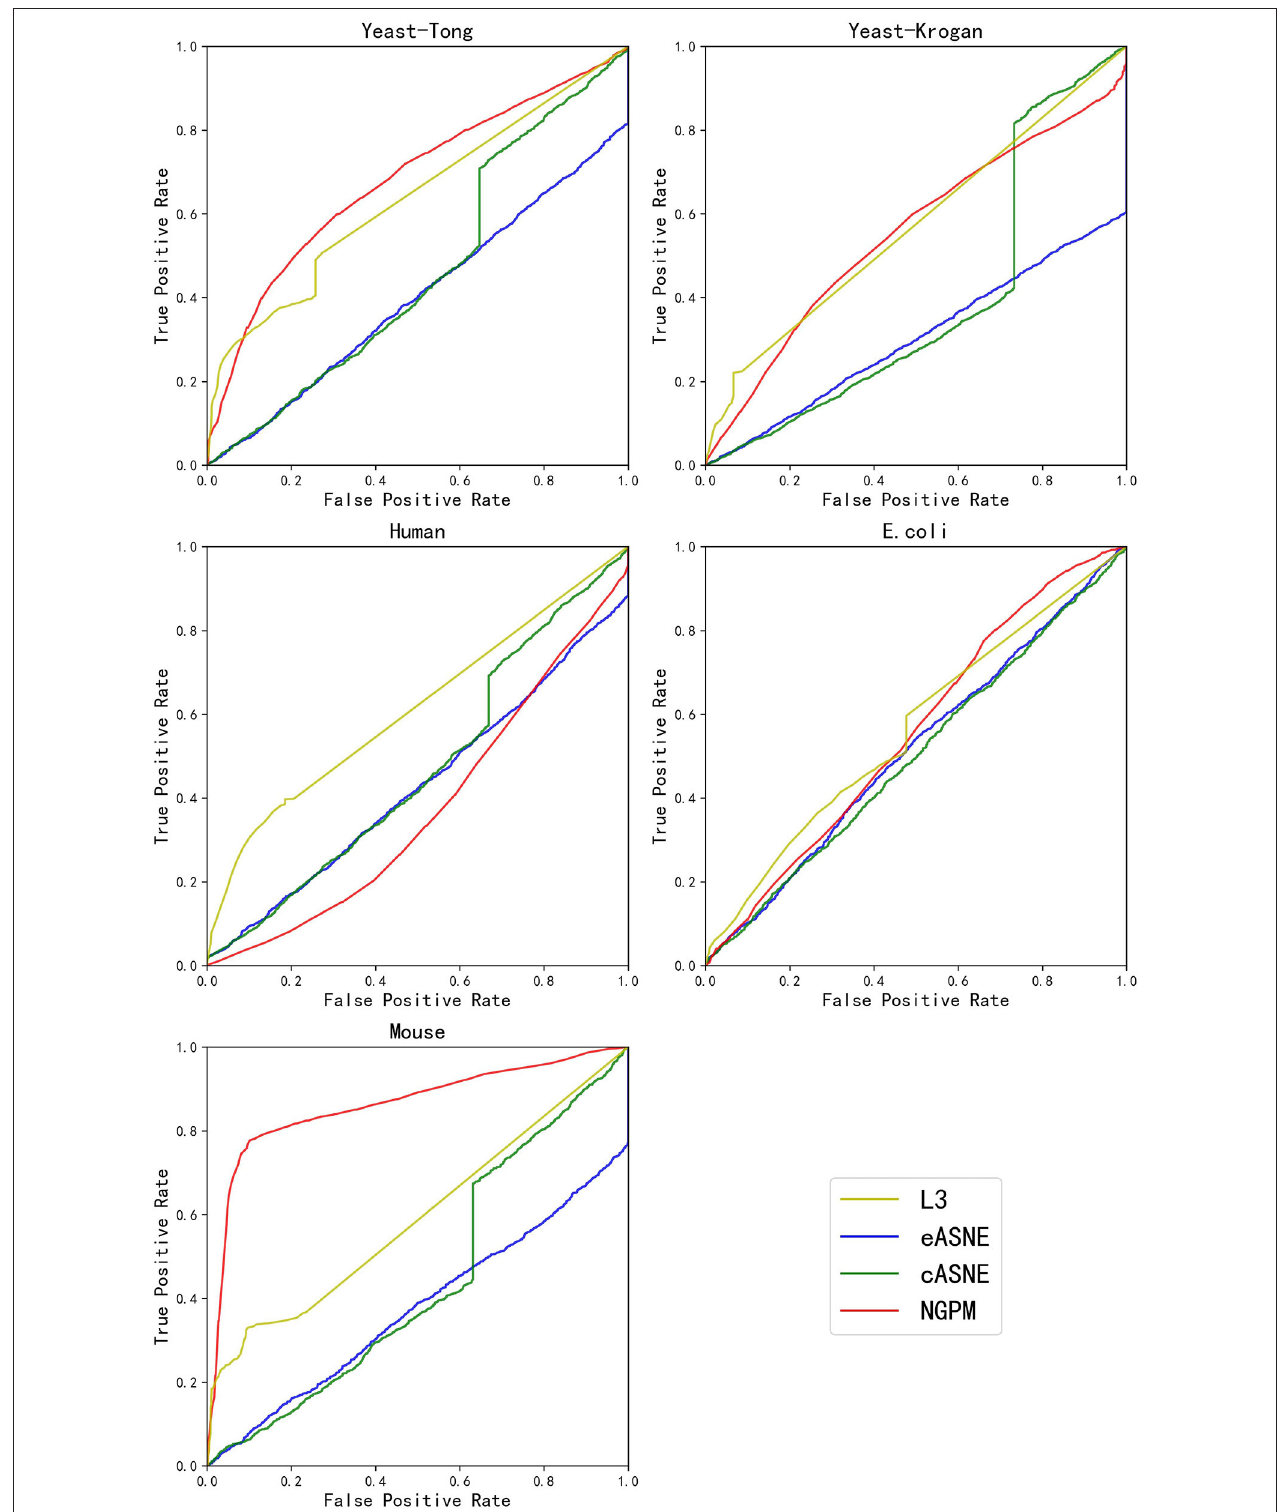
FIGURE 4 | The ROC curves of L3, eASNE, cASNE, and NGPM.